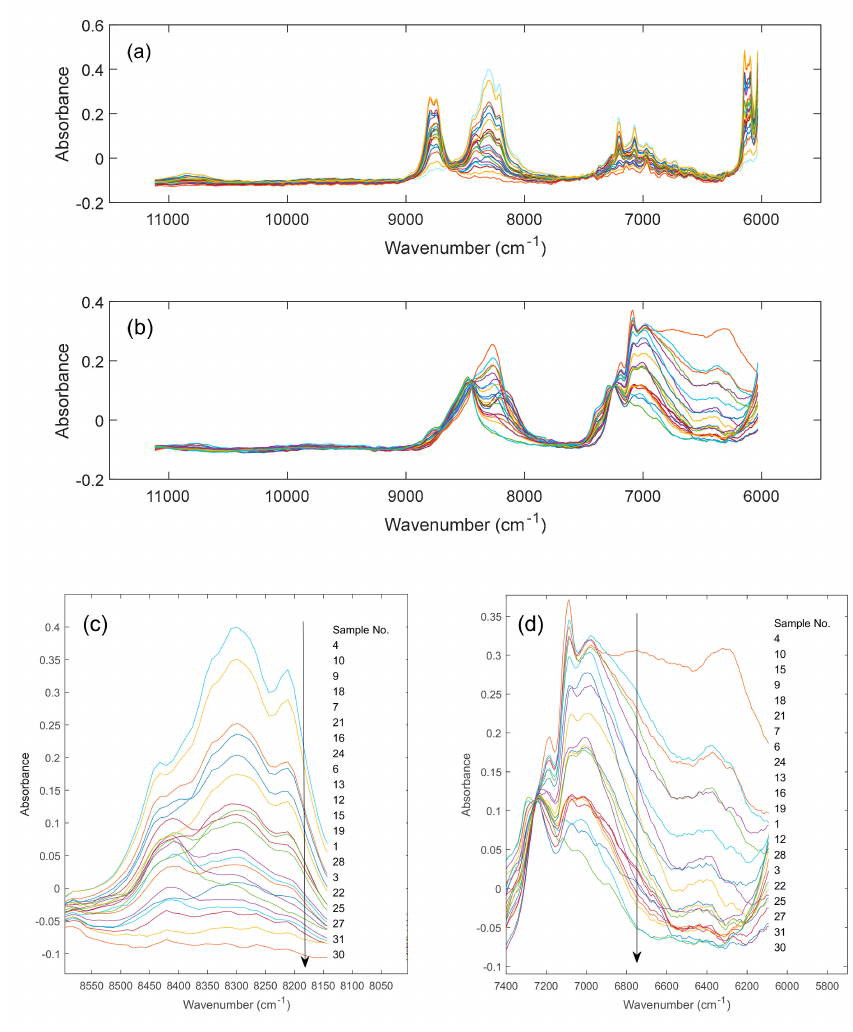
Figure 2. NIR spectra (11,000–6000 cm − 1 ) of the di ff erent three-component solvent mixtures of system 1 ( a ) and system 2 ( b ). In ( c , d ) enlargements for specific wavenumber ranges of ( a , b ) (see text) are